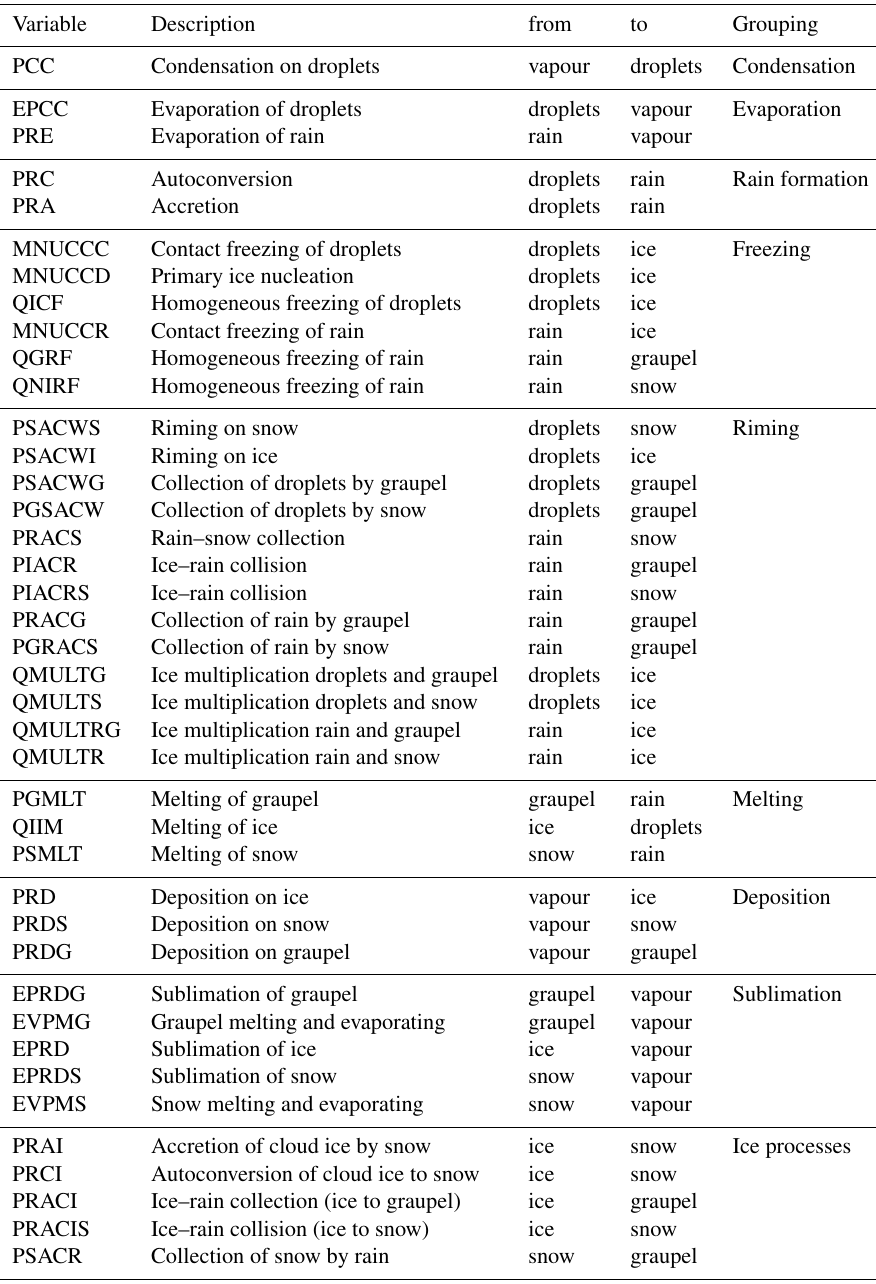
Table B1. Mass transfer process rates for the Morrison microphysics scheme (Morrison et al.,